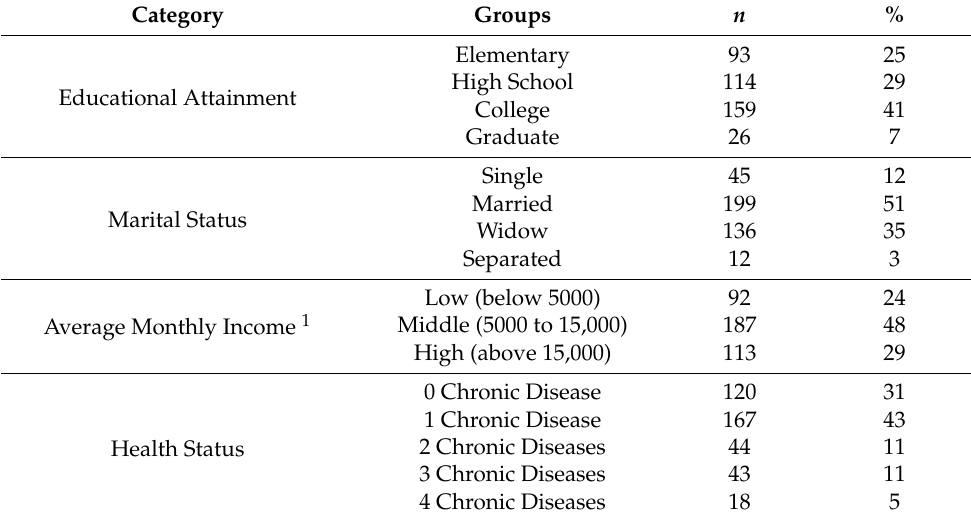
Table 1. Background demographics of the